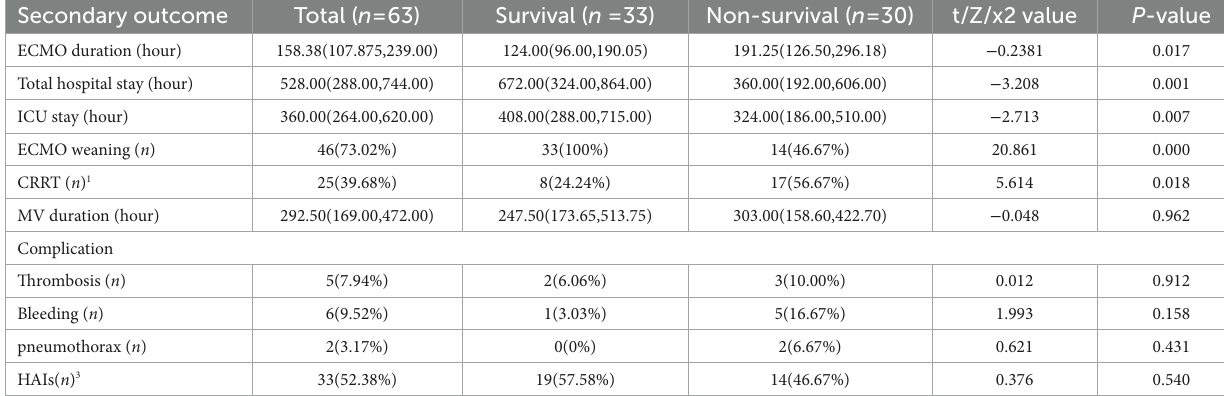
TABLE 2 Comparison of the secondary outcomes between two groups.